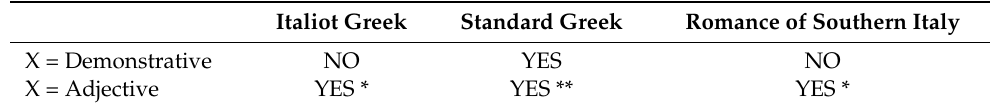
Table 3. Num X N. Table 3. Num X Table 3. Num X N .